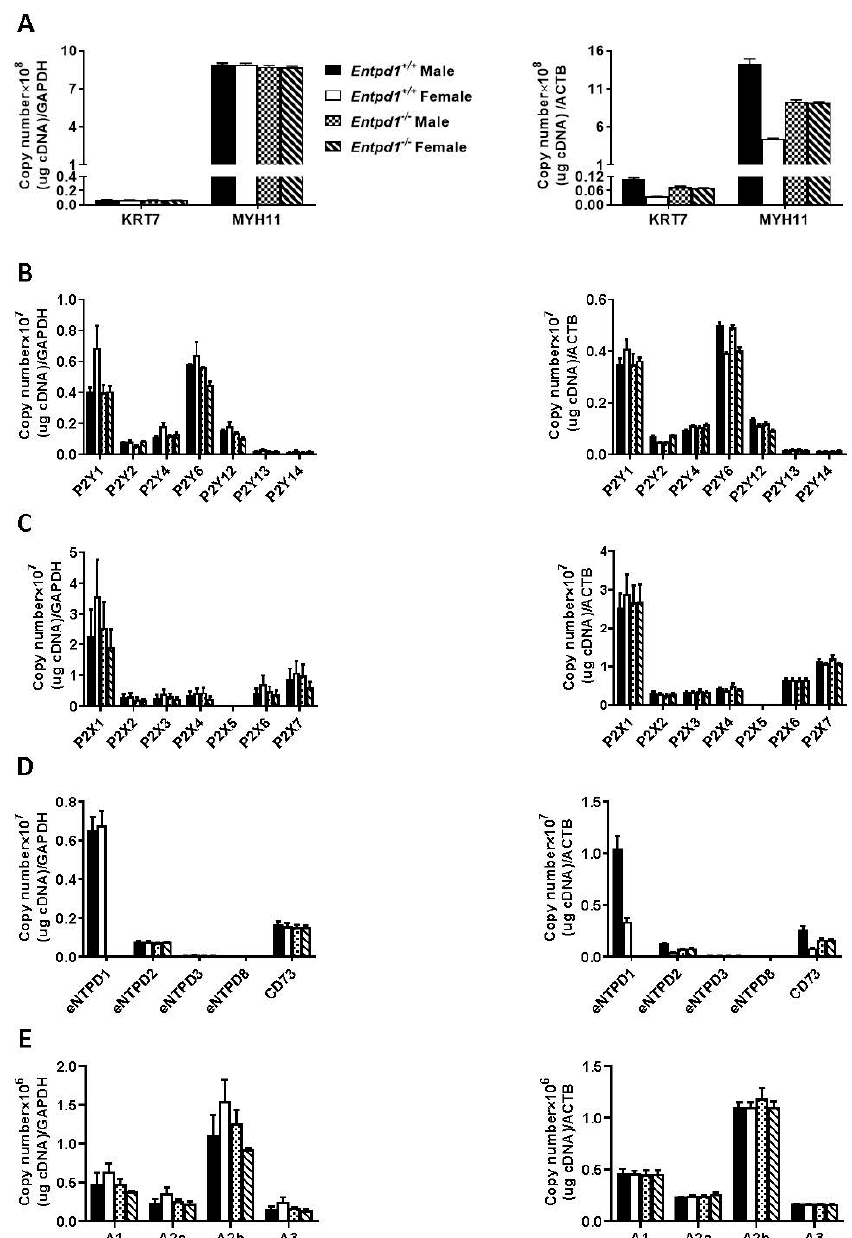
Figure 5. Gene expression profile in male and female bladder SMCs. SMCs were separated from the epithelial layer as mentioned in the “Materials and Methods” section. RNA was isolated from the SMC layer and the expression of the epithelial cell marker Krt7 and the SMC marker Myh11 ( A ), P2Y receptors ( B ), P2X receptors ( C ), ectonucleotidases ( D ), and P1 receptors ( E ) were quantified by RT-qPCR. Data are normalized to GAPDH (glyceraldehyde 3-phosphate dehydrogenase; left panels) and ACTB (actin beta; right panels) mRNA level. Entpd1 +/+ : wild type mice. Entpd1 − / − : NTPDase1 deficient mice. Data presented are the means ± SEM of three independent experiments in duplicate each with SMCs pooled from three